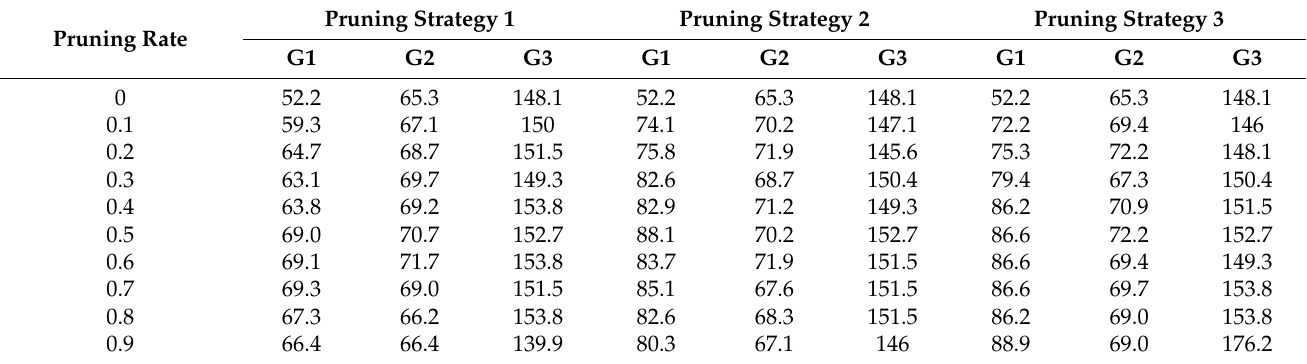
Table 6. The inference speed statistics of the pruned network model on different GPUs